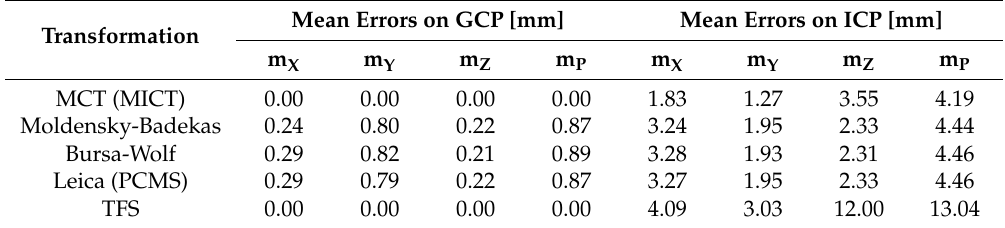
Table 15. Mean errors of transformations (standard deviation) for one of field surveying data set. Mean Errors on GCP [mm] Mean Errors on ICP Transformation